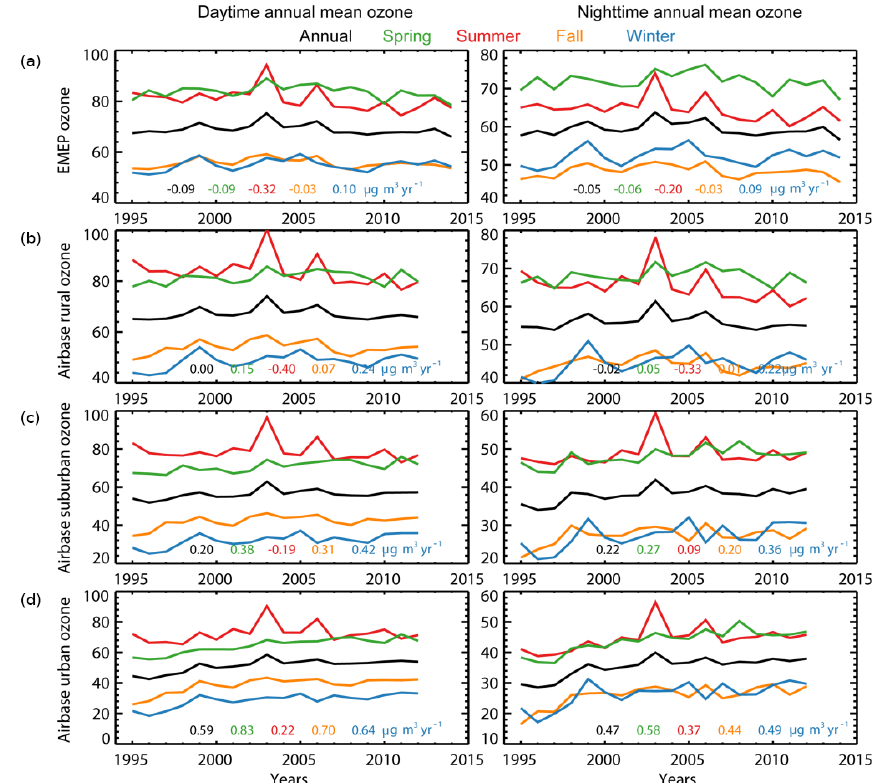
Figure 2. Annual and seasonal mean daytime and nighttime ozone mixing ratios, averaged over the selected sites for EMEP network (a) , as well as Airbase network (panel b for Airbase rural sites; panel c for Airbase suburban sites; and panel d for Airbase urban sites). Also shown in each panel are the relevant